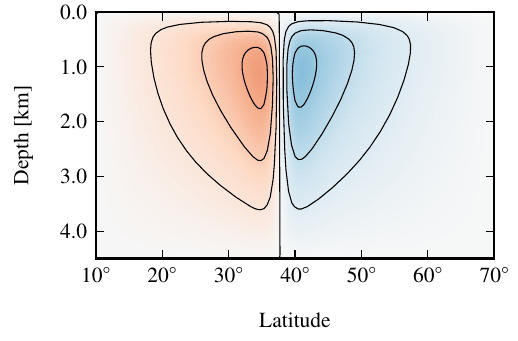
Fig. 9. Overturning stream function ψ (contour interval 2 . 5 × 10 6 m 3 s − 1 ) for the nonconvective case. Red shading indicates pos- itive values; blue shading indicates negative values.